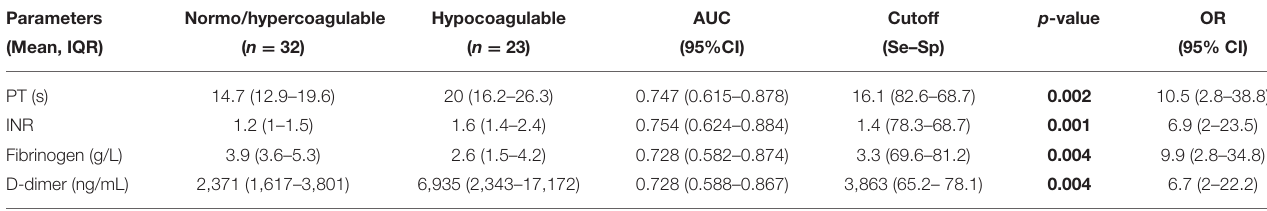
TABLE 3 | Cutoff point of conventional parameters in the discrimination of hypocoagulable phase (based on rotational thromboelastometry).